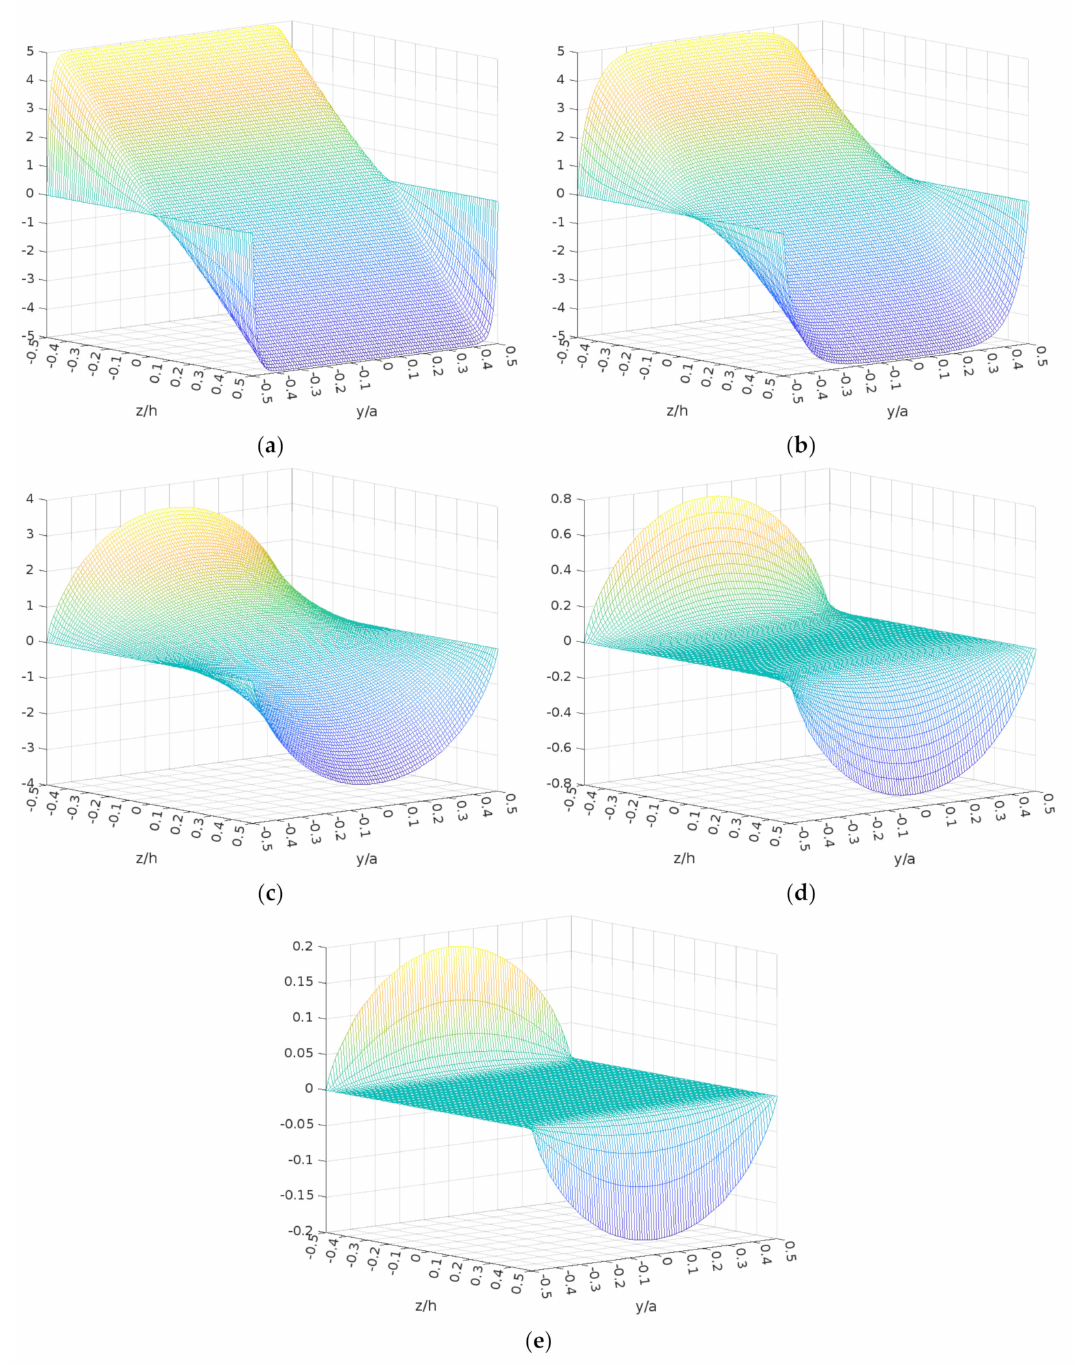
Figure 3. τ xy π 2 J /2 hT verse y / a and z / h ( a ) c = 0.05; ( b ) c = 0.2; ( c ) c = 1; ( d ) c = 5; ( e ) c =